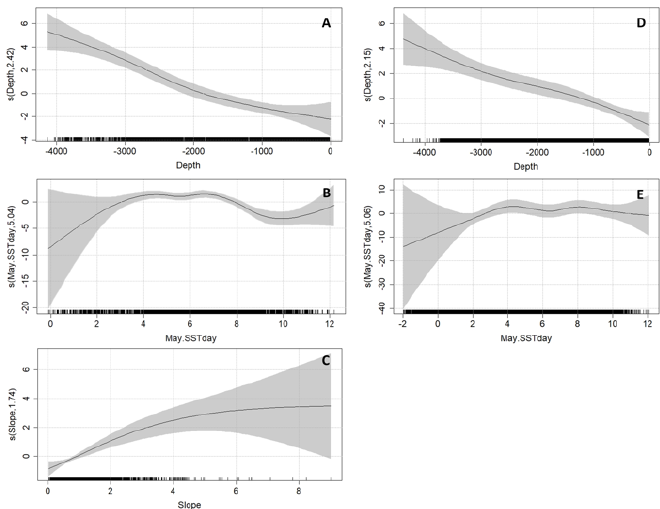
Figure 5. Smooth plots of the covariates included in the simple models. Positive values of the smooth functions (vertical axis) indicate a positive effect on sei whale relative density. Tick marks on the horizontal axis show the distribution of the data. Vertical axis scales vary among plots. Black lines show the lines of best fit, grey shaded areas represent 95% confidence intervals. Panels A-C: SST averaged over 1987-1989, panels D-E: SST averaged over 1998-2015. Panel A: Depth [m] (edf = 2.43, p < 0.0001). Panel B: May SST [ o C] (edf = 5.04, p < 0.0001. Panel C: Slope [ o ] (edf = 1.74, p < 0.0001). Panel D: Depth [m] (edf = 2.15, p < 0.0001). Panel E: May SST [ o C] (edf = 5.06, p <